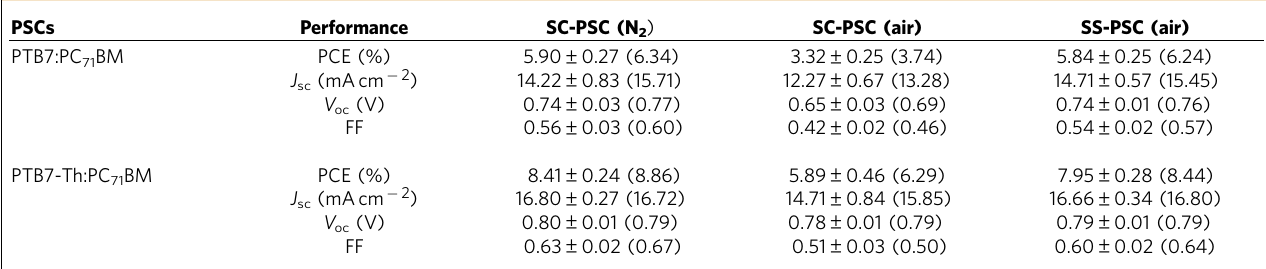
PSCs, polymer solar cells; PTB7, poly[[4,8-bis[(2-ethylhexyl)oxy]benzo[1,2-b:4,5-b’]dithiophene-2,6-diyl][3-fluoro-2-[(2-ethylhexyl) carbonyl]thieno[3,4-b]thiophenediyl]]; SS, spontaneously spreading. Means and s.d. are obtained from 30 devices. The values in brackets illustrates the best cell performance for each device.